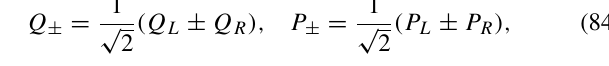
Fig. 7 Illustration of the definition of complexity of purification. We purify the reduced density matrix ρ A in terms of ancilla degrees of freedom on a system A c and optimize the preparation of the state of the combined